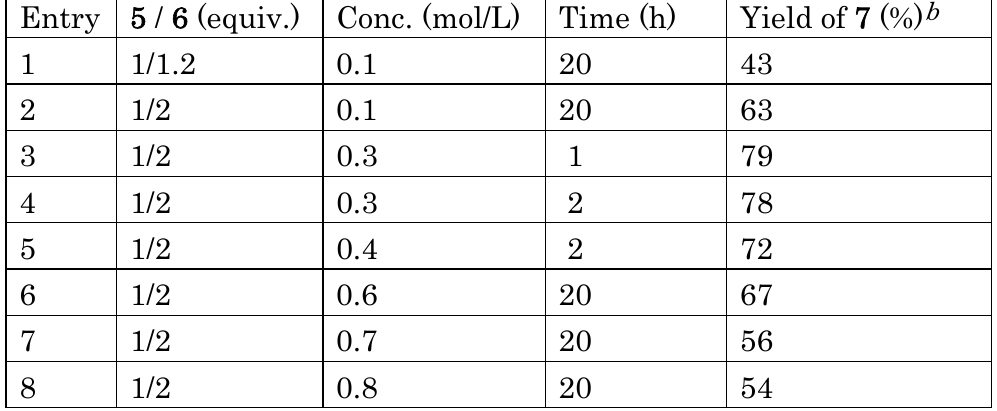
Table 1. Synthesis of 3,4,4-triaryl-1-butene 7 by the three-component coupling reaction among 4-pivaloyloxybenzaldehyde ( 5 ), cinnamyltrimethylsilane ( 6 ), and anisole in the presence of HfCl . 4